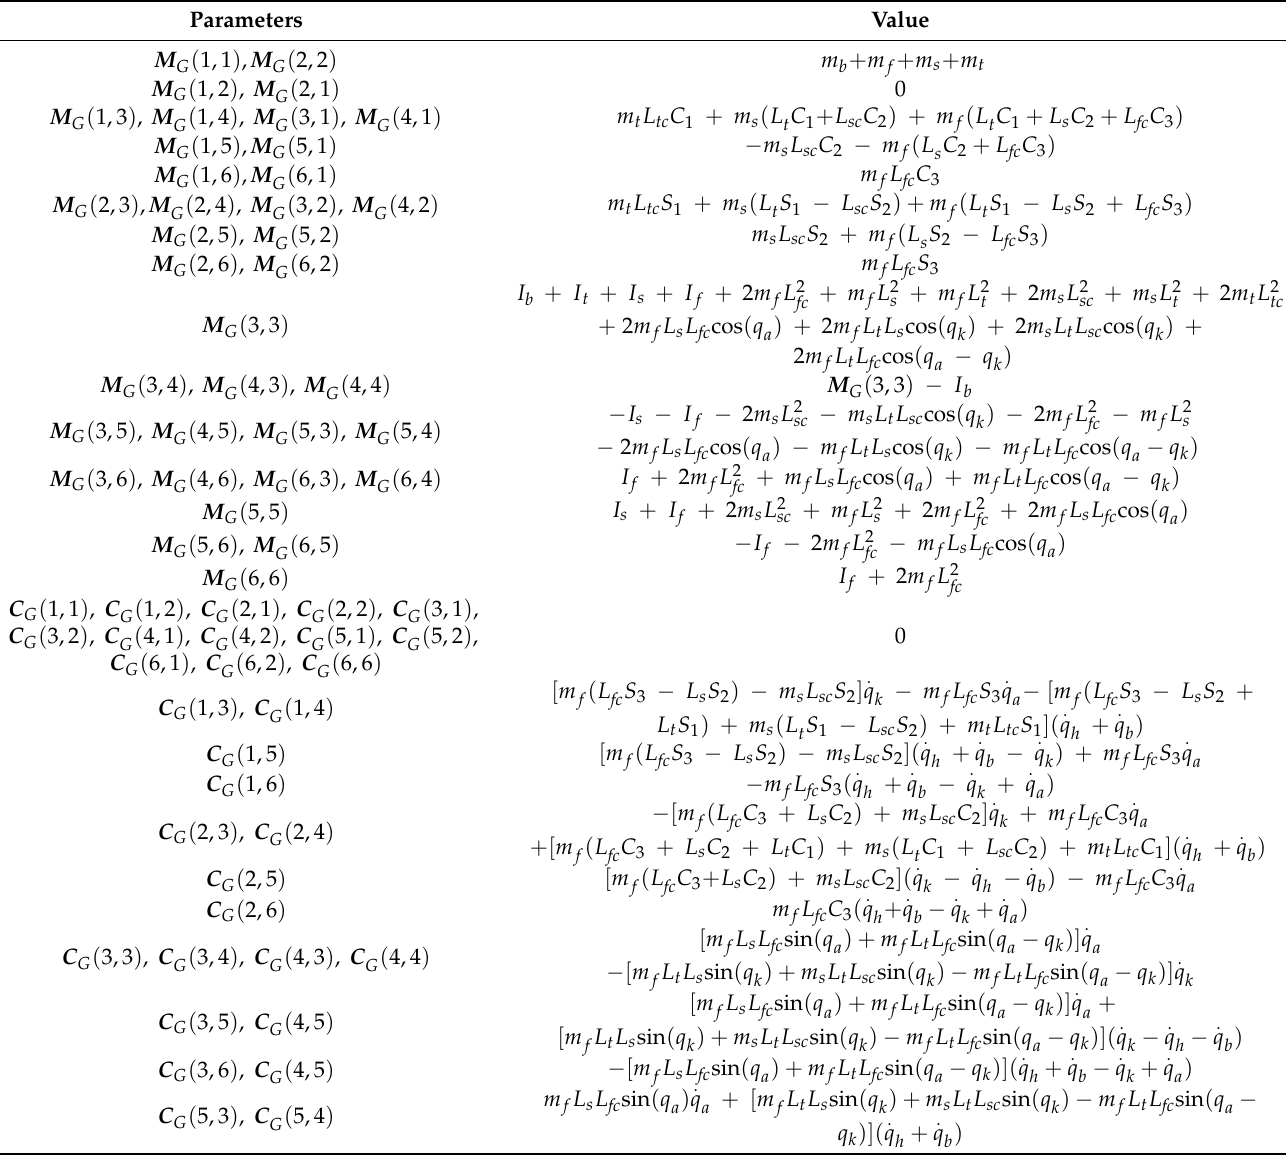
Table A1. The values of parameters in dynamic